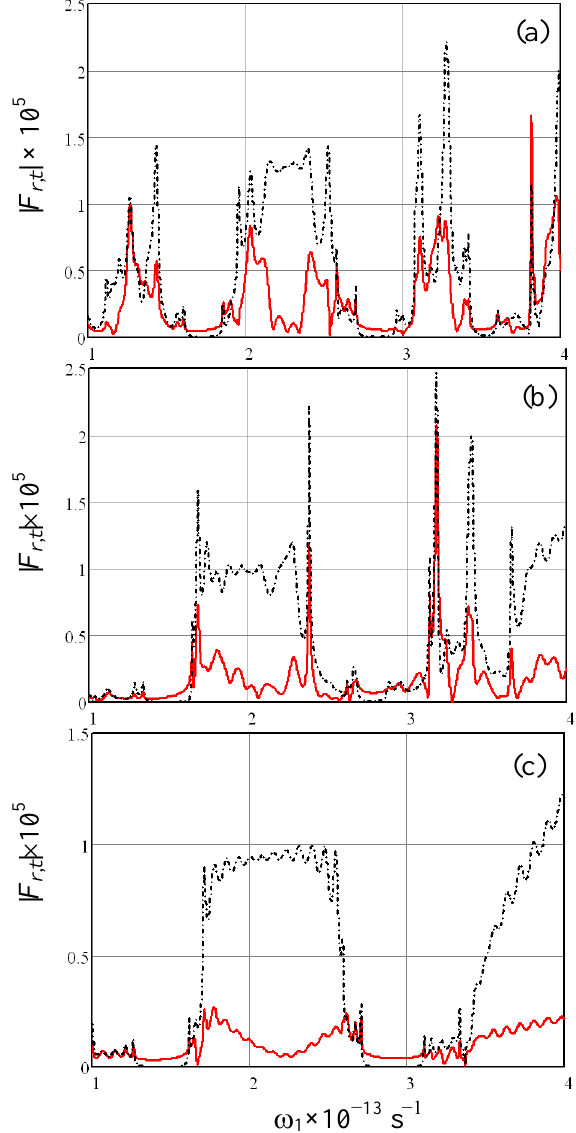
Figure 3. Intensity of field radiated from QPSs at frequency ω = ω + ω in the reverse 3 1 2 (| F |-solid red lines) and forward (| F |-dash-dot black lines) directions of the z -axis: r t ( a ) Fibonacci S stack at ω = 2.01 × 10 13 s −1 ; ( b ) Thue-Morse Q stack at ω = 1.73 × 10 13 s −1 8 2 5 2 and ( c ) periodic stack containing 16 unit cells at ω = 1.76 × 10 13 s −1 . All the stacks are 2 illuminated by pump waves incident at Θ = 30° and Θ = i 1 i 2